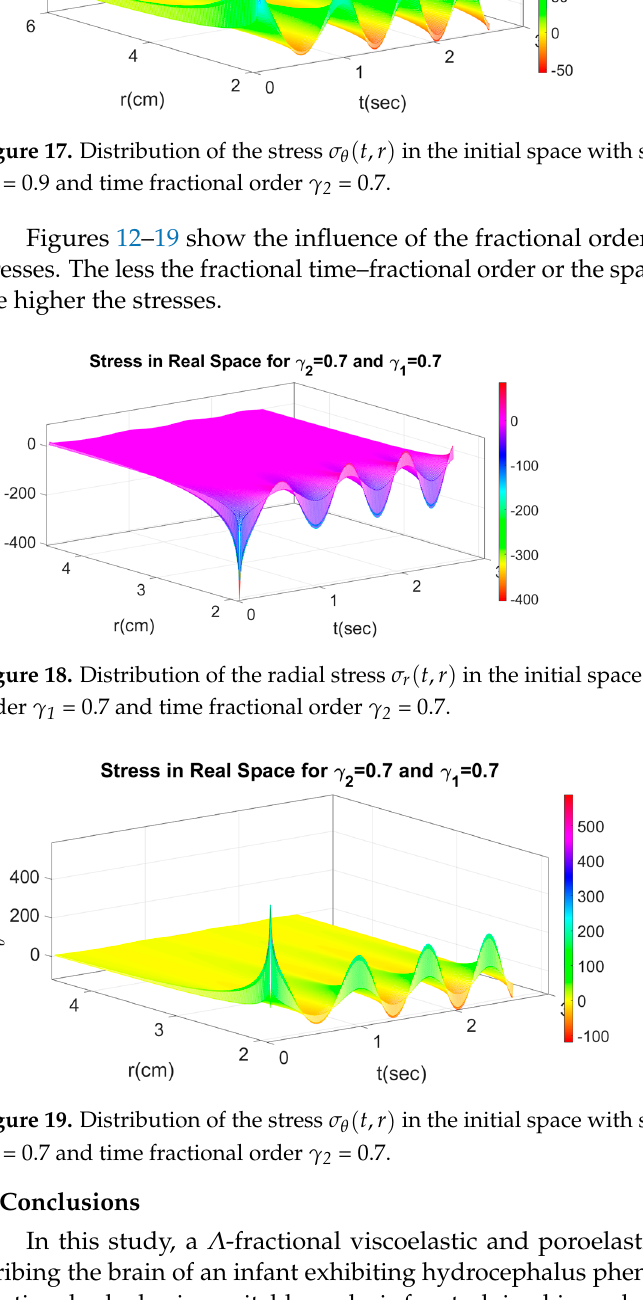
Figure 17. Distribution of the stress σ θ ( t , r ) in the initial space with space (porosity) fractional order γ 1 = 0.9 and time fractional order γ 2 = 0.7.